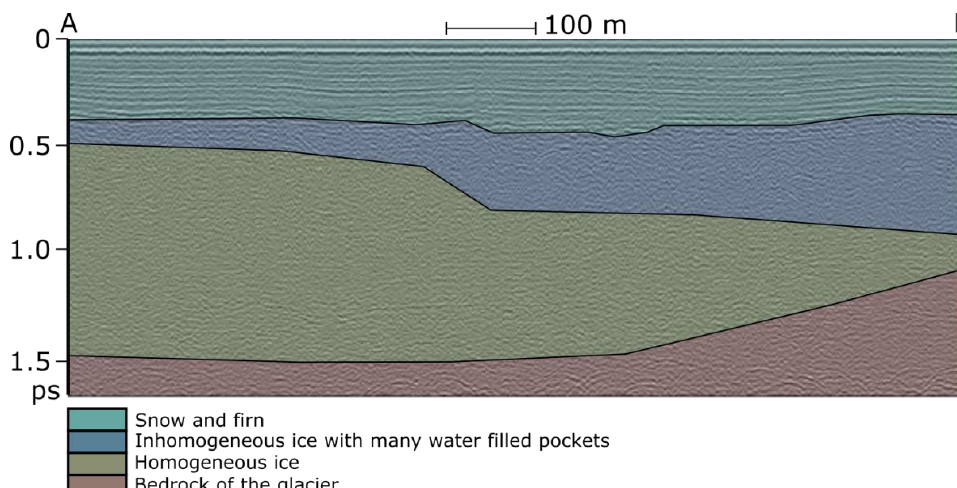
Figure 16. GPR-derived AB-zoned profile obtained based on radar responses, adapted with permis- sion from Travassos and Simões [105] published by ProAntar, 2004.